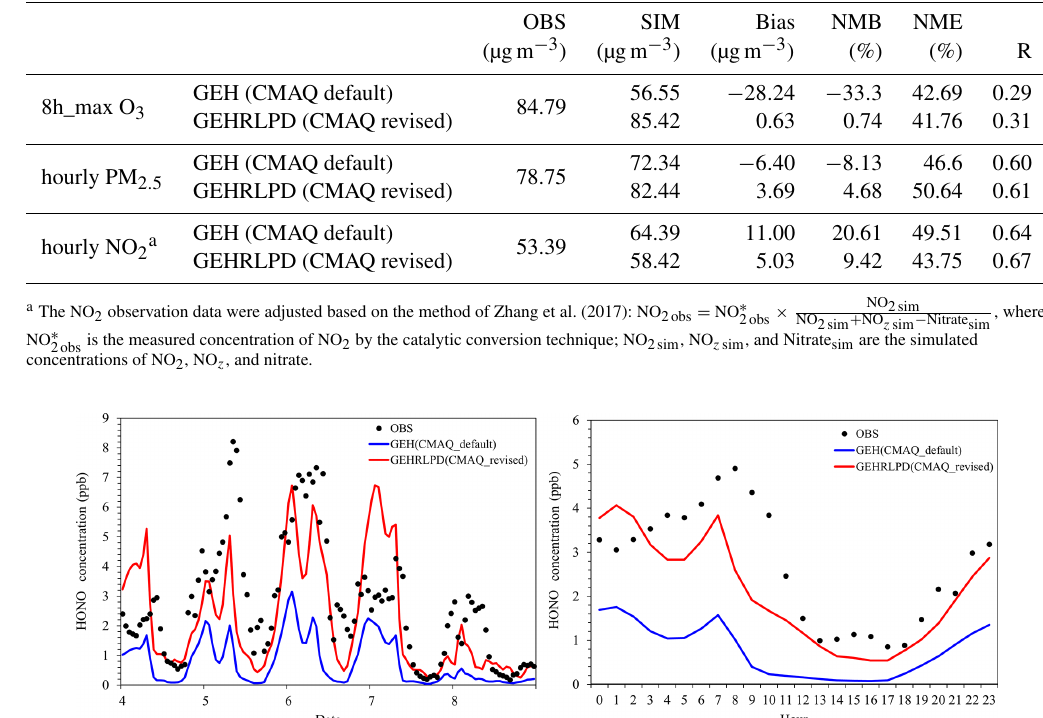
Table 1. Model performance of the default and revised CMAQ model for O 3 , PM 2 . 5 , and NO 2 at 56 monitoring sites in the PRD region.